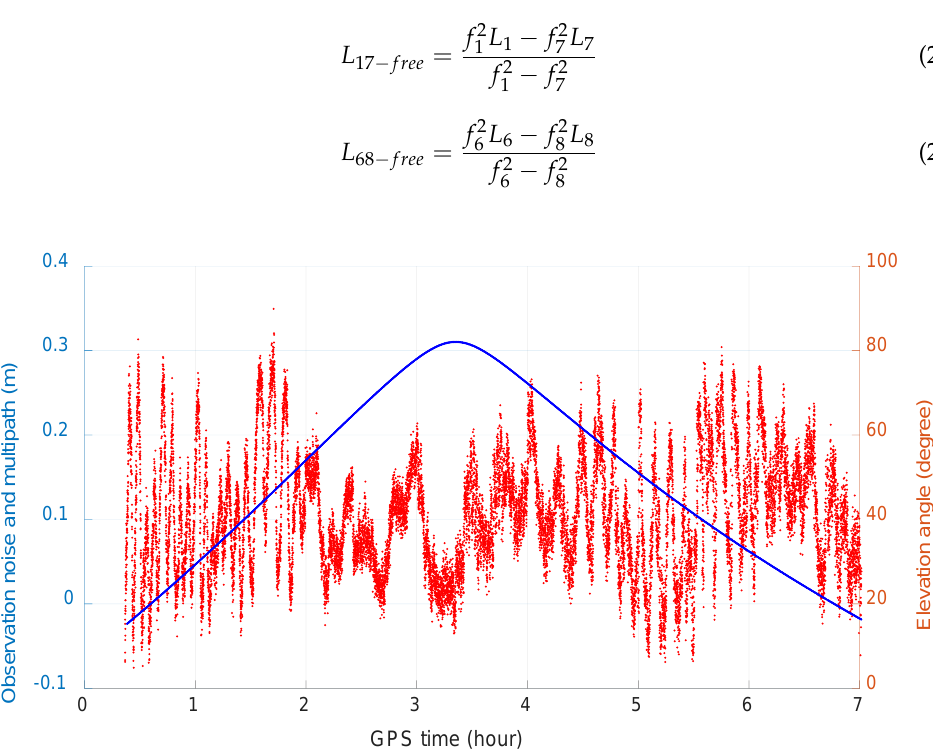
Figure 25. Observation noise and the effect of multipath of Galileo satellite E21.